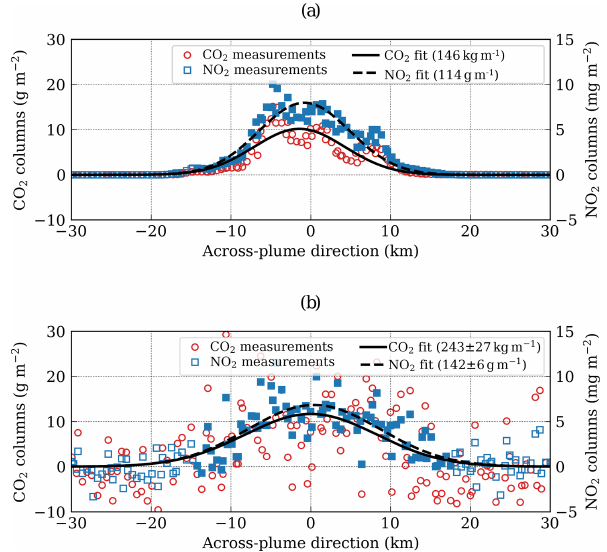
Figure 6. Line densities computed from (a) the model tracer and (b) synthetic satellite observations using the Gaussian curve con- strained by the NO 2